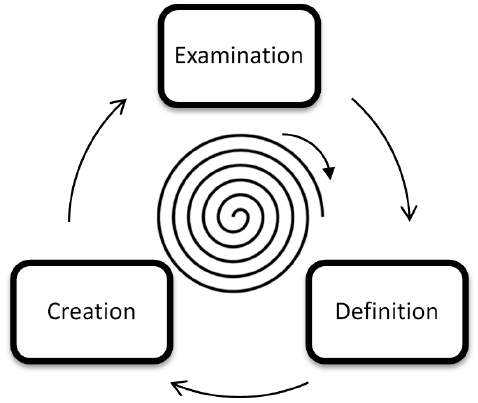
Figure 1. Basic outline of spiral iterative design based on Goodman [11].